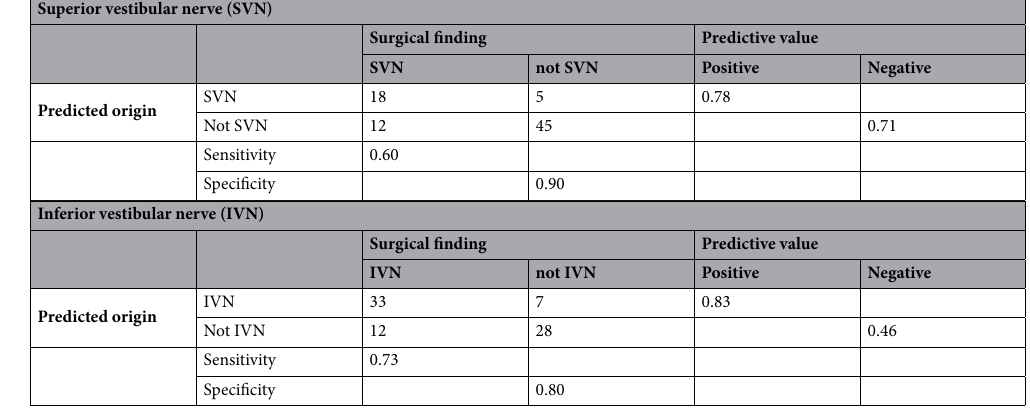
Table 3. Confusion matrix.